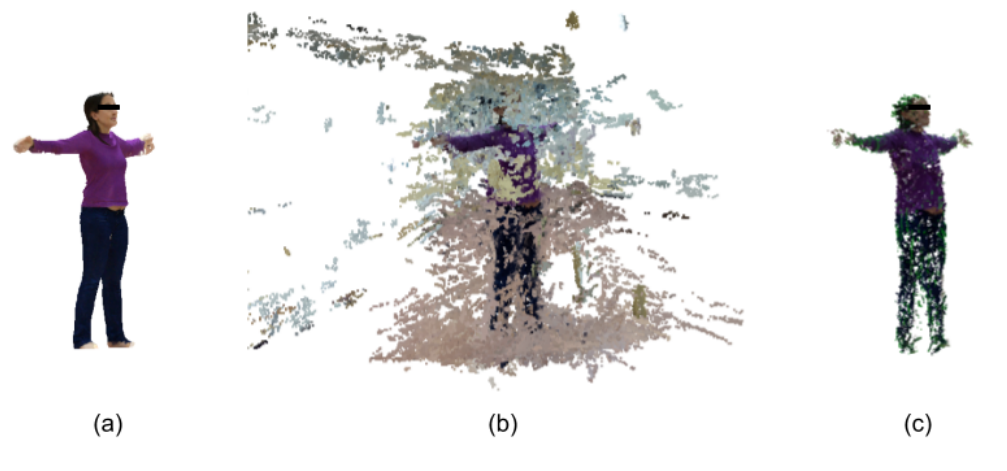
Figure 5. The three 3D full-body reconstructions: ( a ) LiDAR-based mesh cropped, ( b ) structure from motion (SfM)-based point cloud from raw video, and ( c ) point cloud from clean BRemNet -filtered